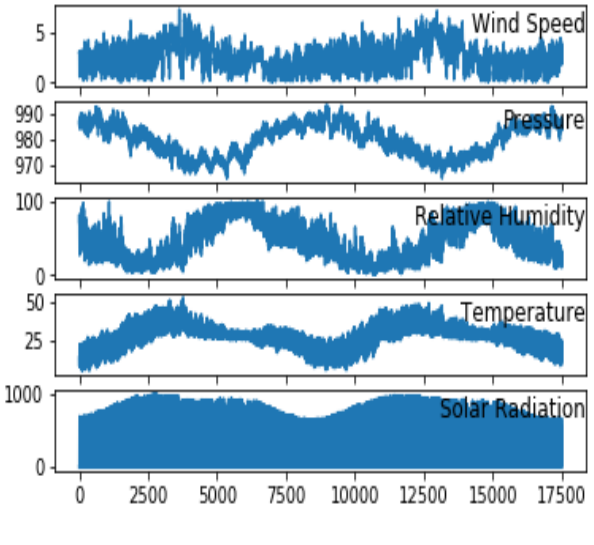
Figure 8. Visualized